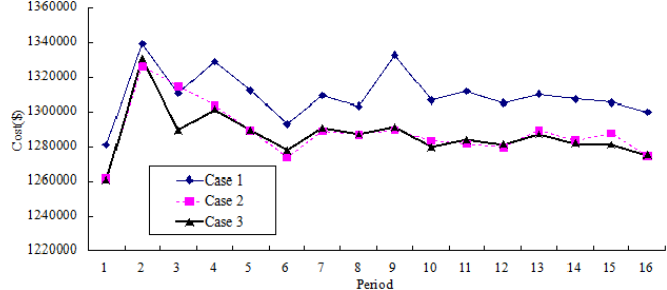
Figure 8. Comparative results of average cost variation (for 16 periods).